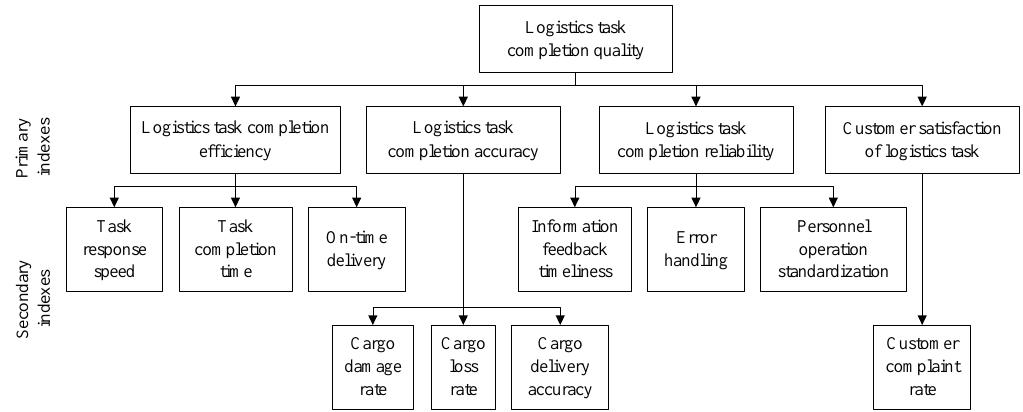
Figure 3. The evaluation index system of logistics task completion quality.